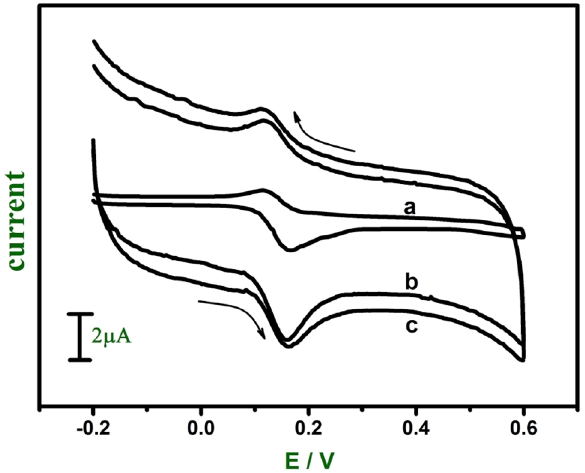
Figure 4. Cyclic voltammograms of 0.02 mM DA at the bare CPE (curve a ), GO (curve b ) and E-GO (curve c ) in 0.2 M phosphate buffer solution at pH 7.0 with sweep rate 0.05 Vs −1 .